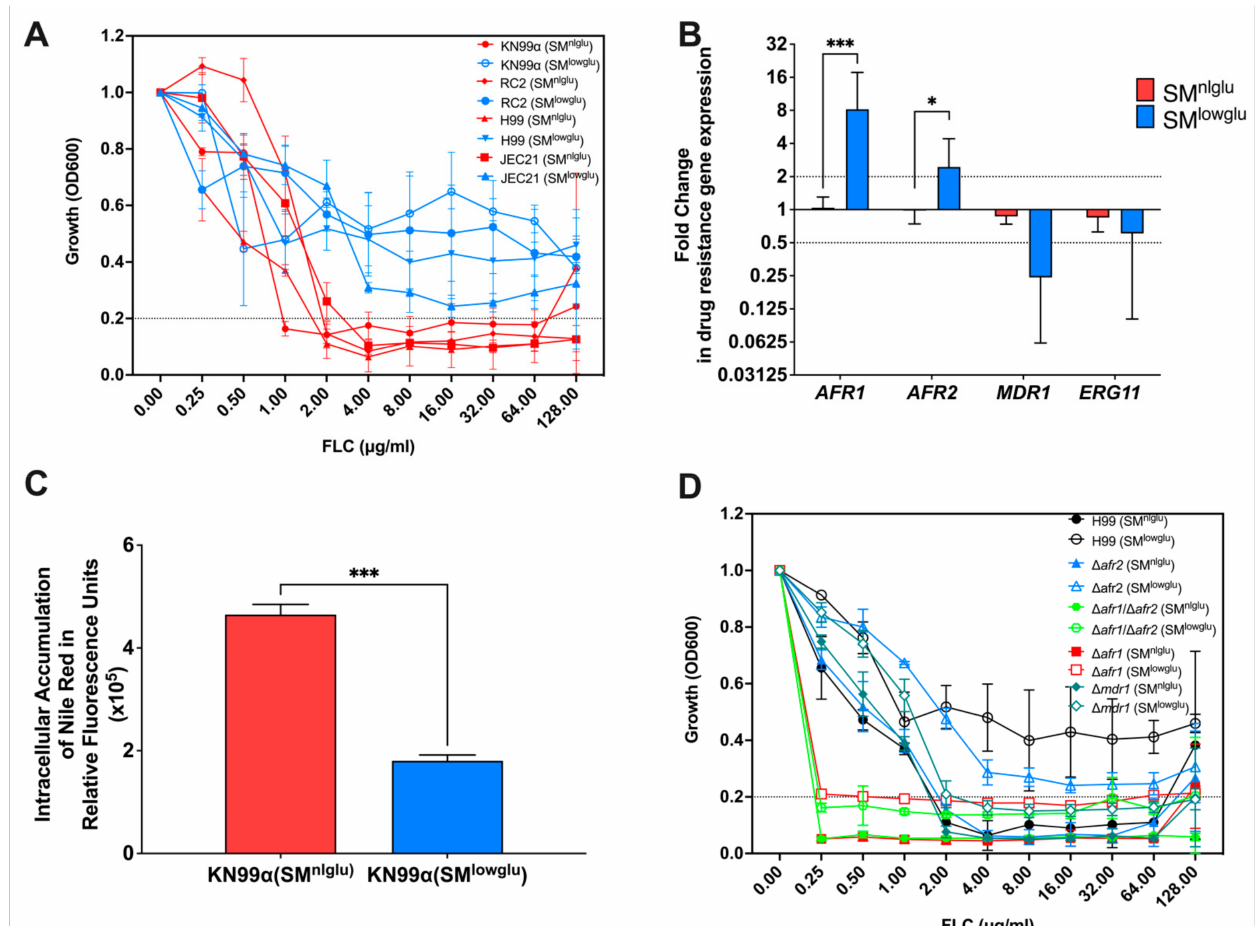
Figure 1. Effects of low glucose in FLC resistance. ( A ) In the presence of low glucose, C. neoformans cells are more resistant to FLC; blue lines signify MICs of different C. neoformans strains in low glucose media, SM lowglu ; red lines signify MICs of different C. neoformans strains in normal glucose media, SM nlglu . Error bars represent the standard deviation between biological triplicates. Dotted line signifies MIC80 cut offs for the respective strains. ( B ) Expression of ABC transporters encoding genes, AFR1 , AFR2 , and MDR1 , and FLC drug target encoding gene ERG11 in SM nlglu (red bar) and SM lowglu (blue bar) media. qPCR was used to analyze the expression of genes in KN99 α cells grown in SM nlglu and SM lowglu media. The data were normalized to the gene expression in the cells grown in SM nlglu media. ACT1 was used as an internal control for the qPCR. The dotted lines signify two-fold up- or downregulation of the respective genes. qPCR was performed in biological triplicate and error bars signify standard deviations in the triplicates. Student’s t -test with Welch’s correction was performed to determine the p -value (* p < 0.05; *** p < 0.001). ( C ) Nile Red accumulation assay to determine efflux efficiencies of the ABC transporters in KN99 α cells in SM nlglu (red bar) and SM lowglu (blue bar) media. Higher accumulation signifies lower efficiency of efflux. The assay was performed in biological triplicate. Error bars signify the standard deviations between the replicates. Student’s t -test with Welch’s correction was performed to determine the p -value (*** p < 0.001). ( D ) MICs of the mutants encoding the efflux pump genes in SM nlglu (closed symbols) and SM lowglu (open symbols) were analyzed. Error bars signify standard deviations between the biological triplicate. Dotted line signifies MIC80 cut offs for the respective